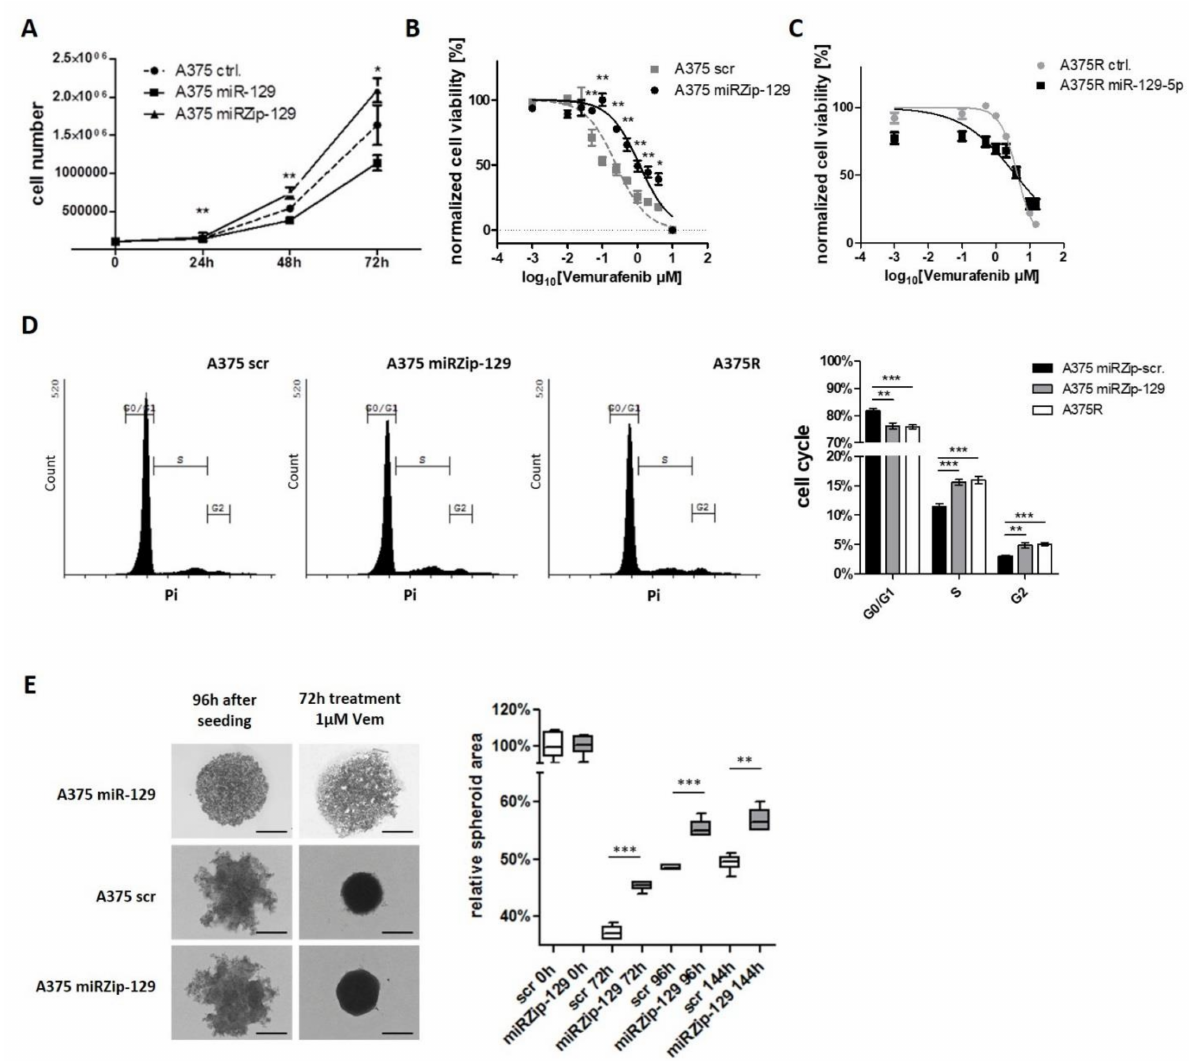
Figure 4. miR-129-5p acts as a tumor suppressor. ( A ) Proliferation Assay of A375 cells overexpressing miR-129-5p (A375 miR-129) and knockdown miR-129-5p (A375 miRZip-129) compared to parental A375 (control). ( B ) BRAFi treatment response of miR-129-5p knockdown cells (A375 miRZip-129) and ( C ) BRAFi resistant cells overexpressing miR-129-5p (A375R miR-129) using cell viability assay. ( D ) Cell cycle distribution of sensitive parental A375 cells and their corresponding Vemurafenib resistant clone (A375R) compared to miR-129-5p knockdown cells (A375 miRZip-129). ( E ) Representative photographs of spheroid growth after initial Vemurafenib treatment (1 µ M) were taken at indicated time points. Scale bar represents 500 µ m. Spheroid area was measured of at least 5 spheroids using ImageJ software. Bars represent average of at least three independent experiments. * p ≤ 0.05; ** p ≤ 0.01; *** p ≤